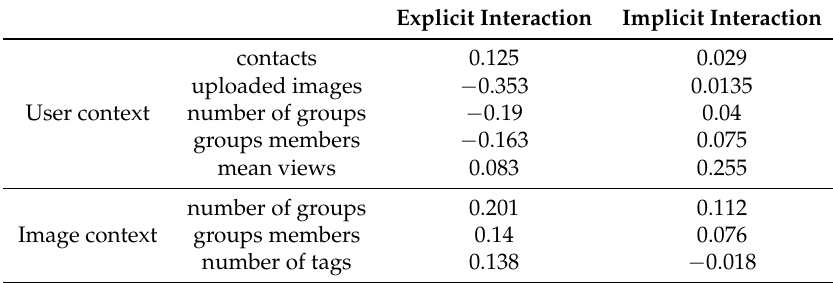
Table 4. Correlation between social factors and social interactions for the representative dataset.